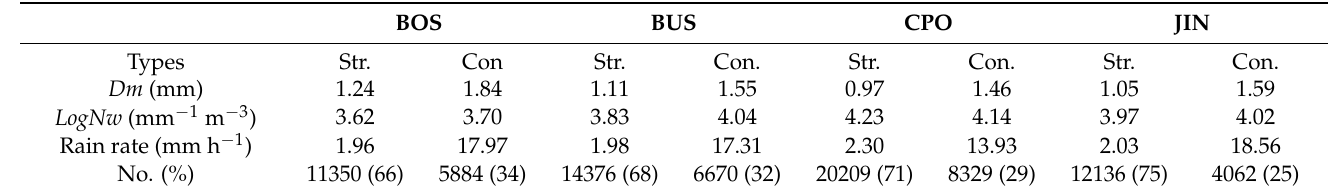
Table 1. The average DSDs variables, rain rates, and sample numbers of rain types at the four studied sites.